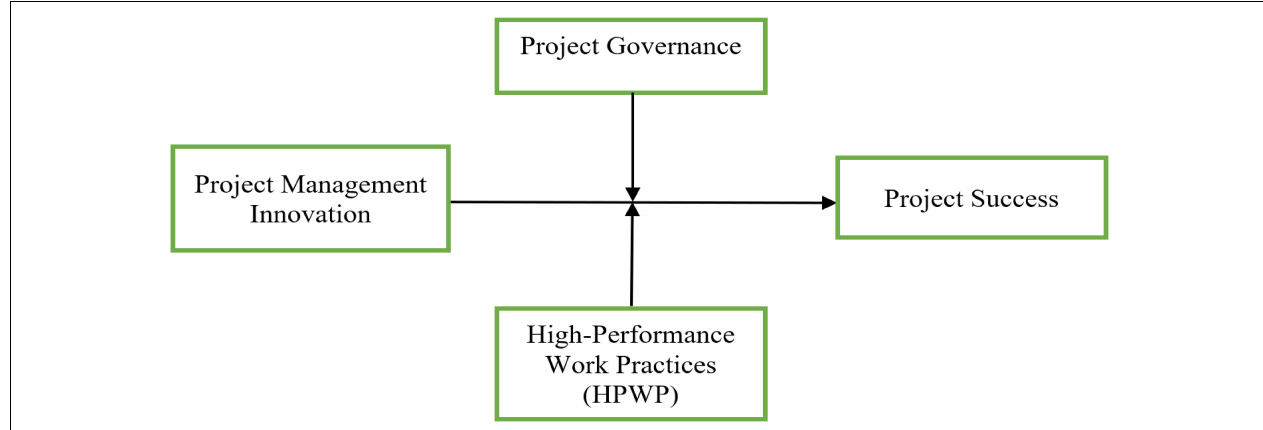
FIGURE 1 | Conceptual